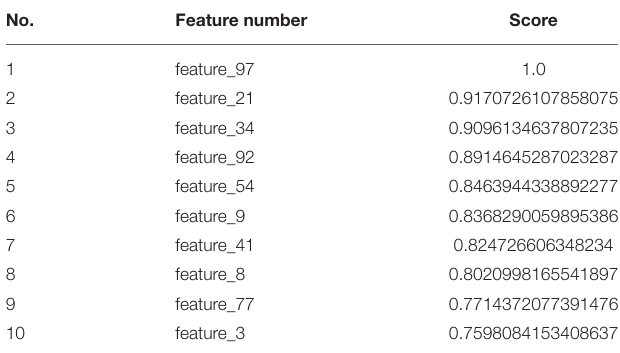
TABLE 3 | Top-ranked features using MRMD feature selection